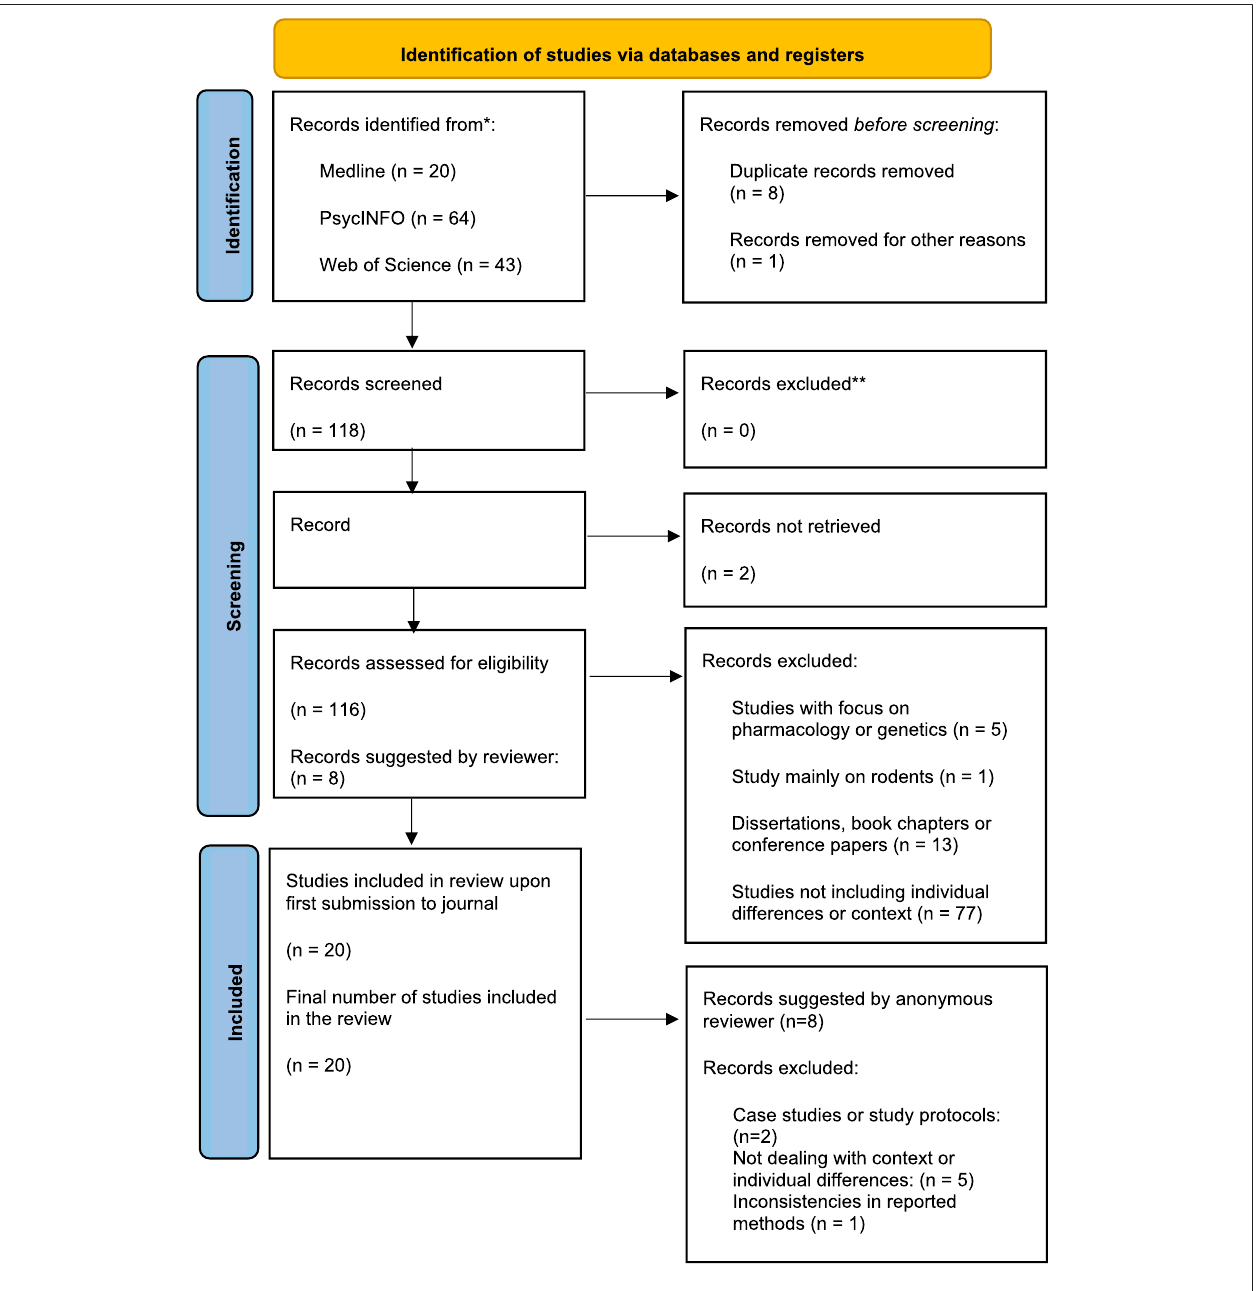
FIGURE 1 | PRISMA-ScR Flow